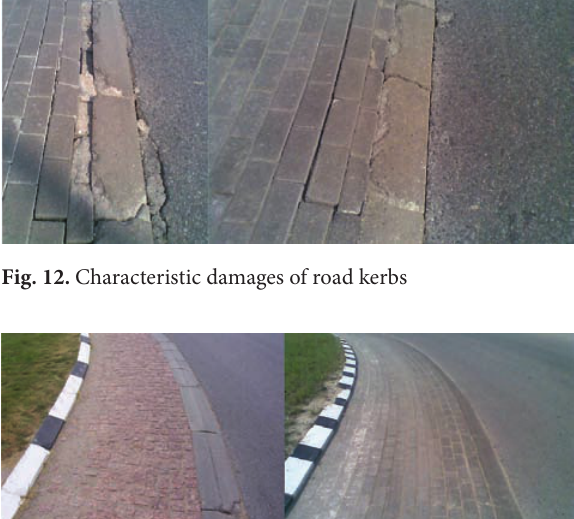
tres thick sand